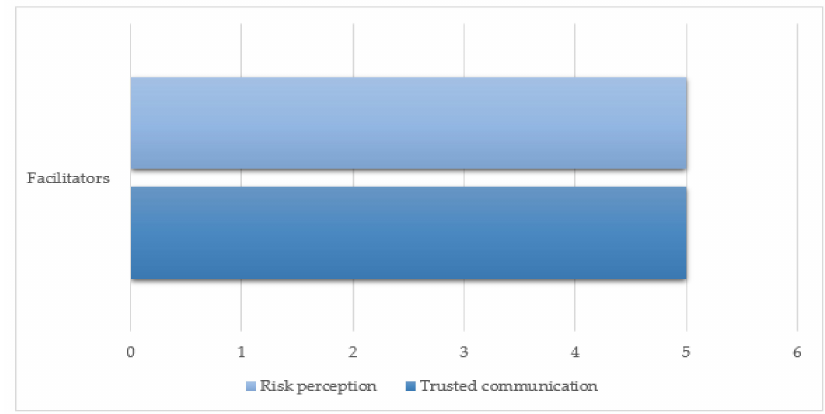
Figure 3. Distribution of facilitators of COVID-19